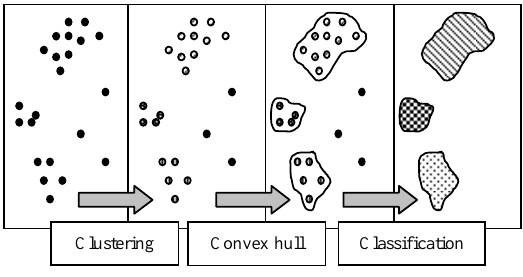
Figure 3: Generating location contexts from